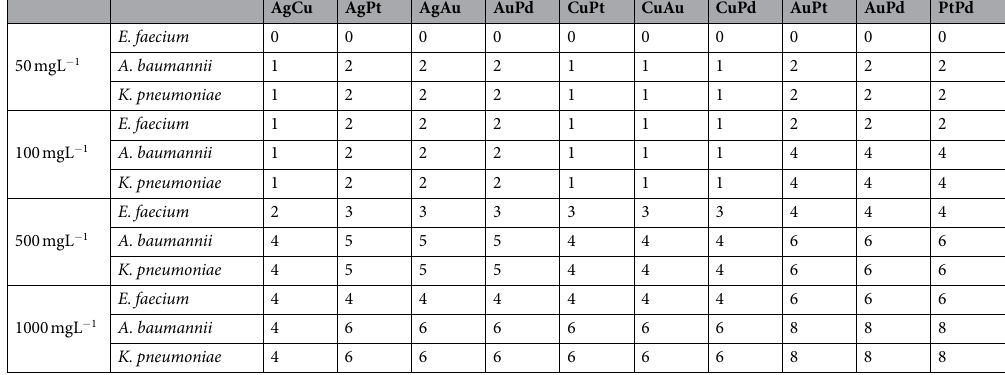
Table 1. Zone of inhibition assays for metal combinations against E. faecium, A. baumannii and K. pneumoniae (mm) demonstrating that platinum/palladium, gold/palladium or gold/platinum demonstrated the greatest antimicrobial activity. Au = gold, Cu = copper, Pt = platinum, Pd = palladium and Ag = silver (n = 3). The inhibition zones were graded from 0 to 4, which measured as, 0–4 mm = grade 0, 4–8 mm = grade 1,